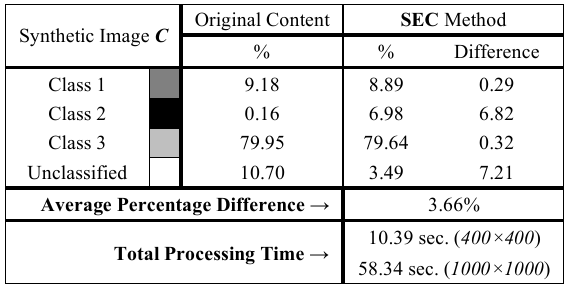
Table 4. Comparative table of the class percentages obtained by the SEC method for the synthetic image C